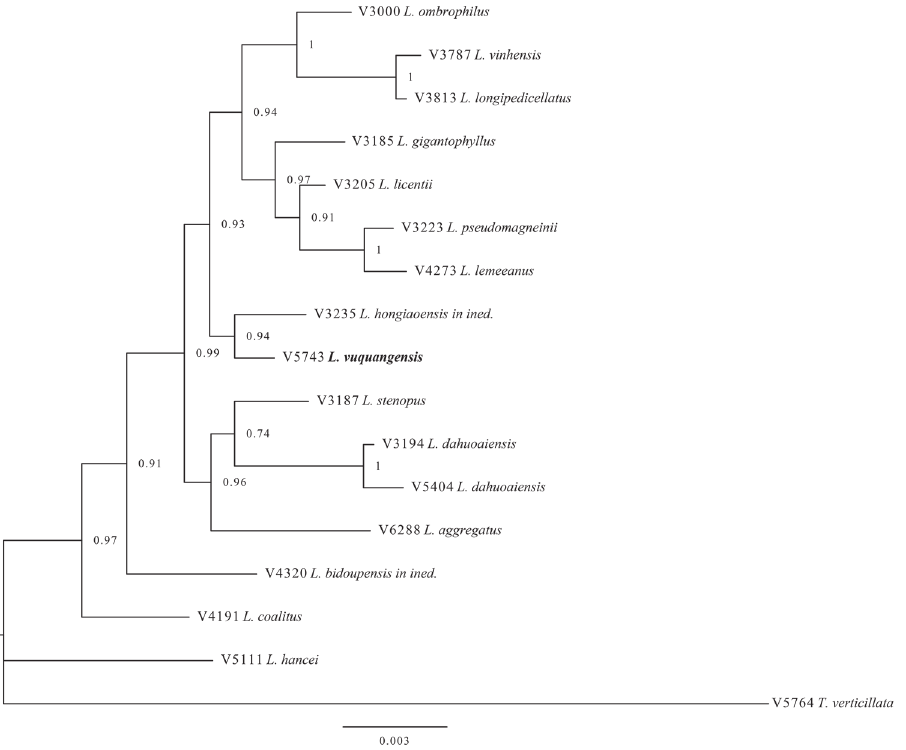
Figure 2. Bayesian phylogeny estimate of 15 taxa of Lithocarpus and one Trigonobalanus verticillata (as an outgroup) based on combined rbcL , matK and ITS sequences. Branches are labelled with posterior probabilities greater than 0.7.